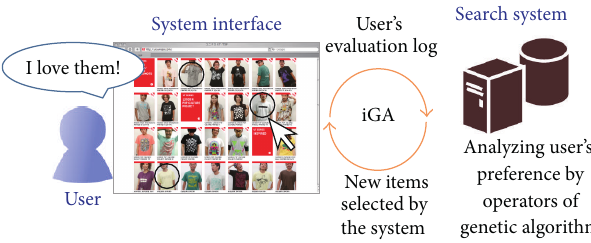
Figure 1: Overview of a product recommendation system using an iGA.